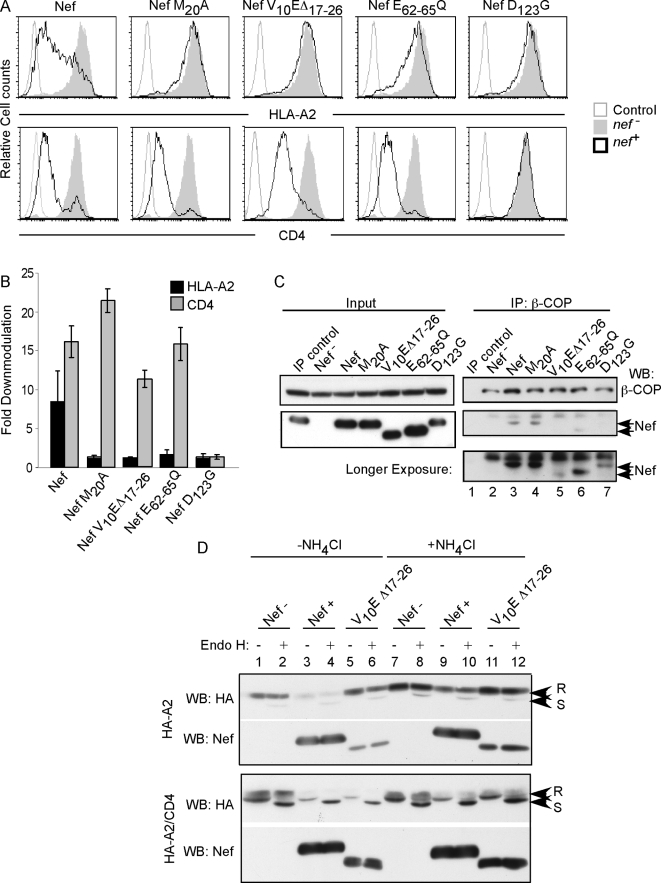
Co-precipitation of Nef and β-COP depends on domains of Nef
that are also needed for MHC-I downmodulation.(A) Flow cytometric analysis of Nef mutants defective at MHC-I
downmodulation. CEM T cells treated with control adenovirus
(nef−), adeno-Nef
(nef+) or the indicated
mutant were stained either with an anti-HLA-A2 antibody (BB7.2) or an
antibody directed at CD4. Cells were analyzed by flow cytometry as
described in Materials and Methods.
(B) Quantitation of MHC-I and CD4 downmodulation by Nef and Nef mutants.
Fold downmodulation was determined by dividing the mean fluorescence
intensity (MFI) of control virus treated cells by the MFI of
Nef-expressing cells. The average value from three (wild-type) or two
(mutant Nef) experiments was plotted±the standard deviation.
(C) Nef D123G and V10EΔ17–26
mutants are defective at β-COP binding. CEM T cells were treated
with control adenovirus (nef−),
adeno-Nef (nef+), or the indicated
mutant and immunoprecipitated with a control antibody (BB7.2) or an
antibody directed against β-COP (M3A5). The presence of Nef was
detected by western blot analysis. Arrows indicate the positions of wild
type Nef and Nef V10EΔ17–26. Results are
representative of at least two independent experiments. (D)
V10EΔ17–26 Nef is defective at MHC-I, but
not CD4, degradation. CEM cells expressing HA-HLA-A2 and HA-A2/CD4 were
transduced with adeno-viral vectors encoding wild-type Nef
(Nef+), V10EΔ17–26
Nef, or a control adenoviral vector (Nef−). Two
days later, the media on half of the cells was replaced with media
containing 20 mM ammonium chloride to inhibit lysosomal degradation. The
next day, the cells were harvested, lysed, and normalized. Each sample
was split equally and one set was treated with endo H. Protein levels of
HA-HLA-A2 and HA-A2/CD4 were assessed by western blot analysis using an
anti-HA antibody. Endo H–resistant bands are marked with an R
and endo H–sensitive bands are marked with an S.